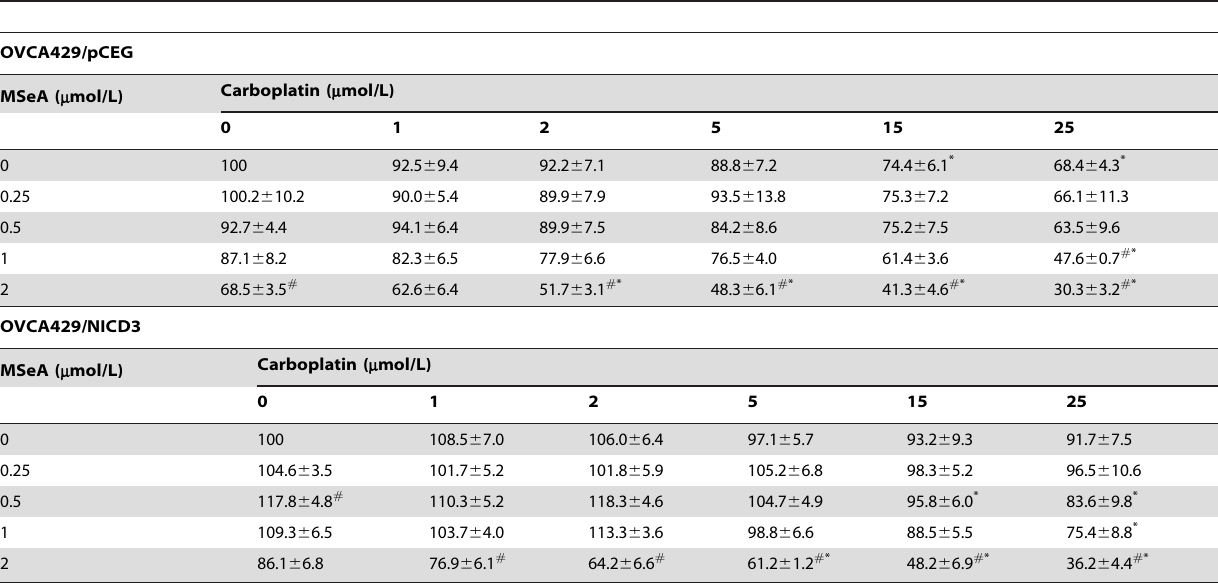
Table 1. Sensitivity of OVCA429/pCEG and OVCA429/NICD3 ovarian cancer cells to MSeA and carboplatin treatment.